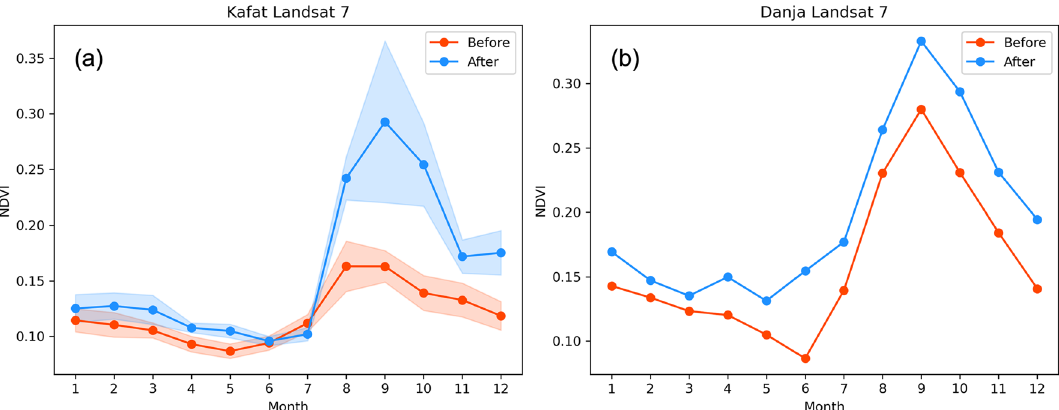
Figure 4. Average monthly NDVI values for two sites, Kafat and Danja, from Landsat 7 before and after the intervention. The shaded areas on the left side panels represent one standard deviation computed from multiple polygons at each site.